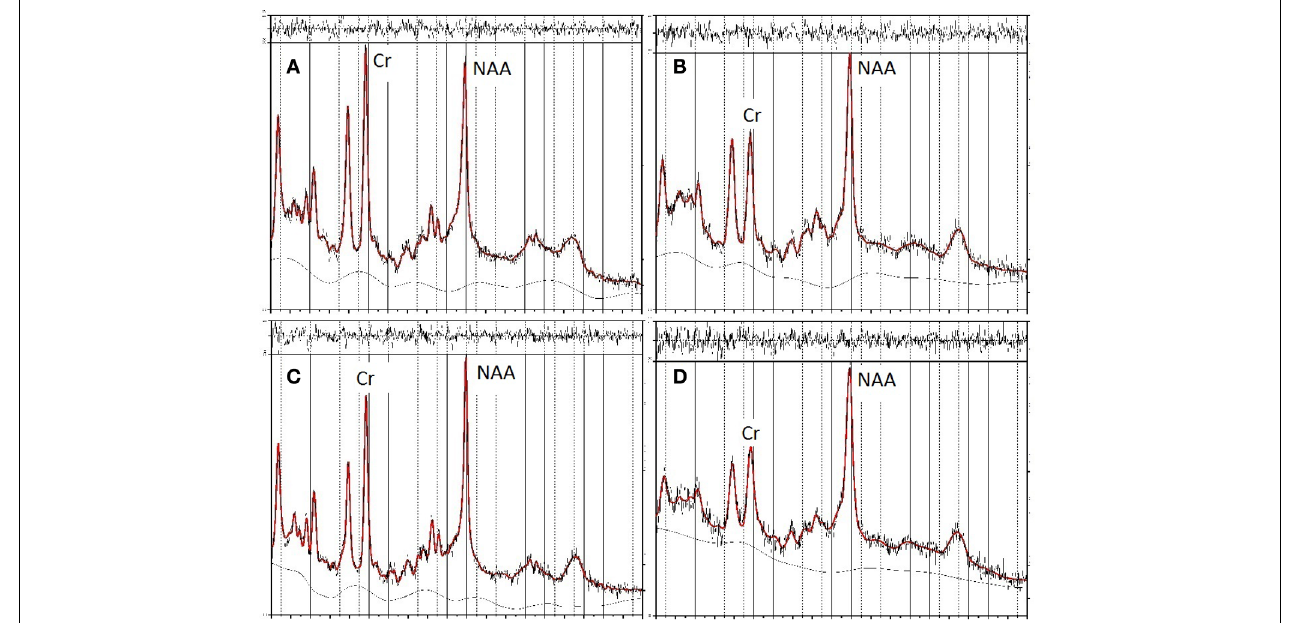
FIGURE 2 | LCModel spectra of unscreened data showing minimum and maximum values for NAA in frontal (FRO) and occipitoparietal (OP) voxels. The top two panels show the spectra for minimum (A) and maximum